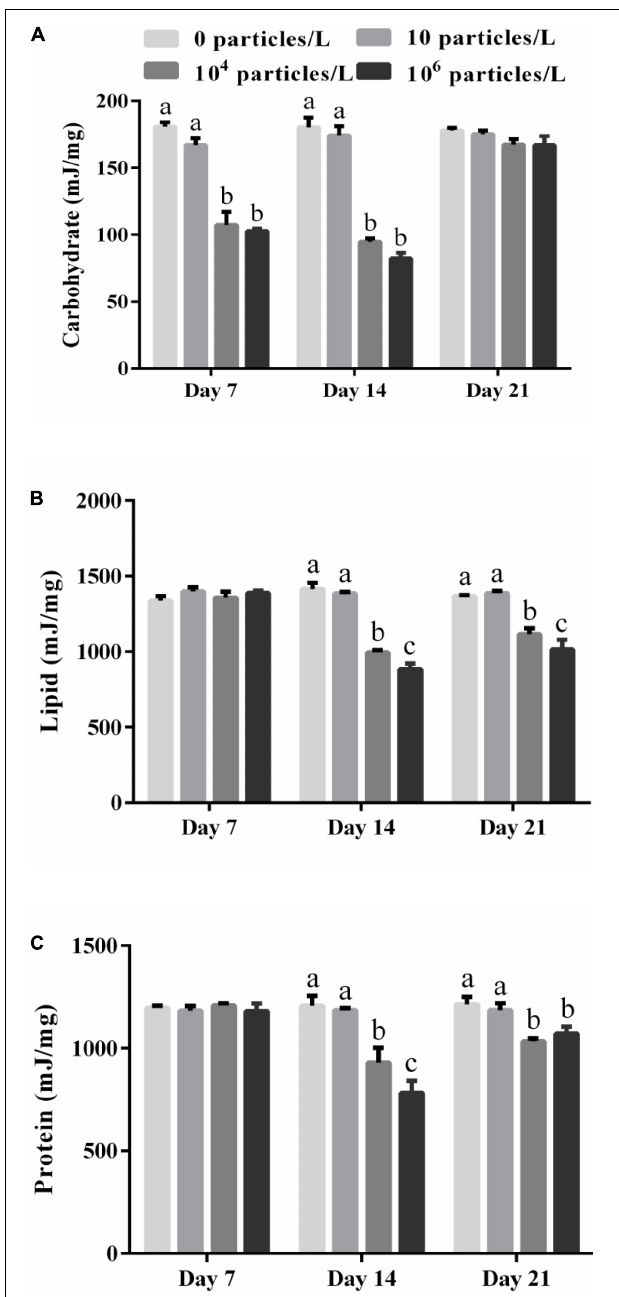
FIGURE 1 | The energy stored in carbohydrates (A) , lipids (B) , and protein (C) in the digestive gland of M. coruscus exposed to different microplastics concentrations (0, 10, 10 4 , and 10 6 particles/L). Different lowercase letters indicate that at the same sampling time point, there are significant differences between different microplastics concentration groups ( p < 0.05), and no letters indicate that at each sampling time point, there are no significant differences between different microplastic concentration groups ( p >